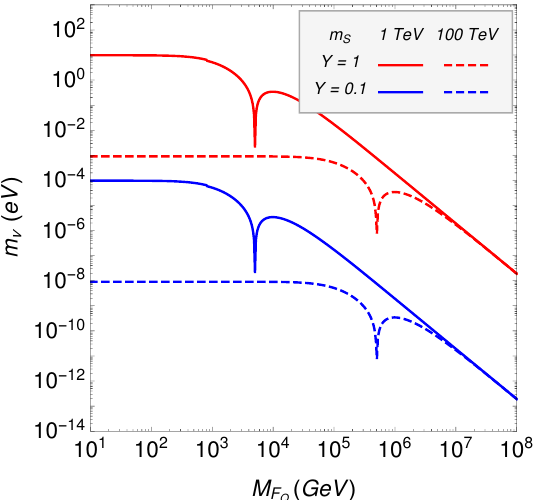
Figure 13 . The neutrino mass scale for model 5 in (cid:12)gure 10, for some example choices of param- eters. See text for